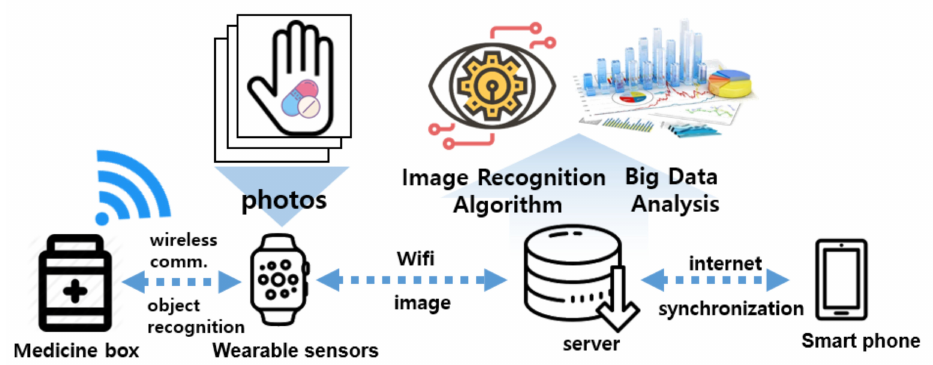
Figure 1. Overview of the medication monitoring system using a wearable device .